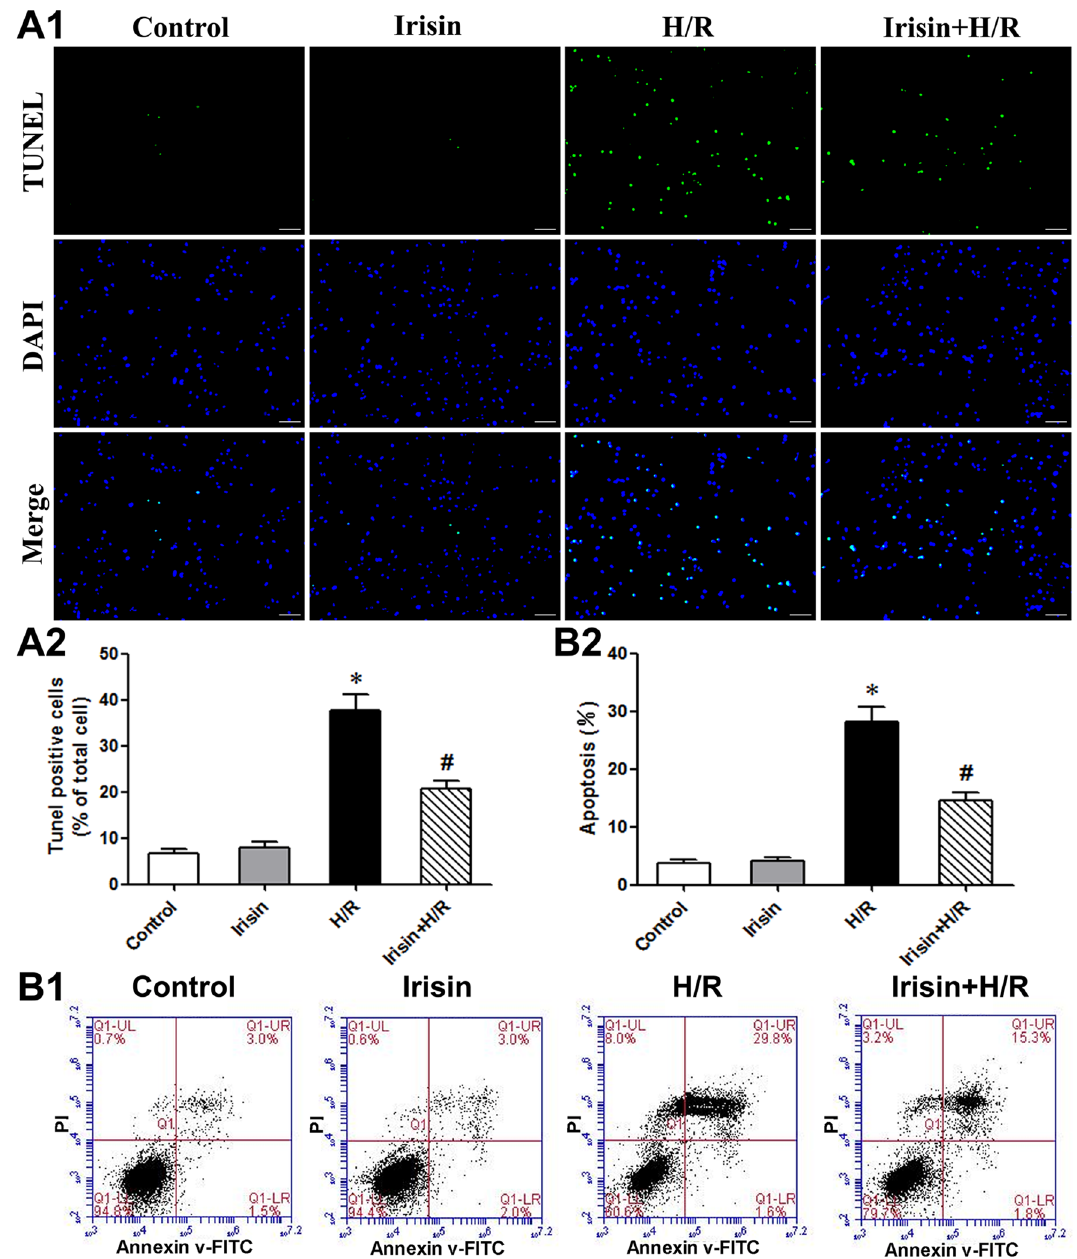
Figure 2. Irisin attenuated H/R-induced cardiomyocyte apoptosis. Representative images ( A1 ) and quantification ( A2 ) of cardiomyocytes in situ TUNEL assay. TUNEL-positive is green, and DAPI is blue. Scale bar: 200 mm. ( B ) Flow cytometry analysis of Annexin-V FITC and propidium iodide staining in cardiomyocytes. * P < 0.05 versus control group, # P < 0.05 versus H/R group, n =